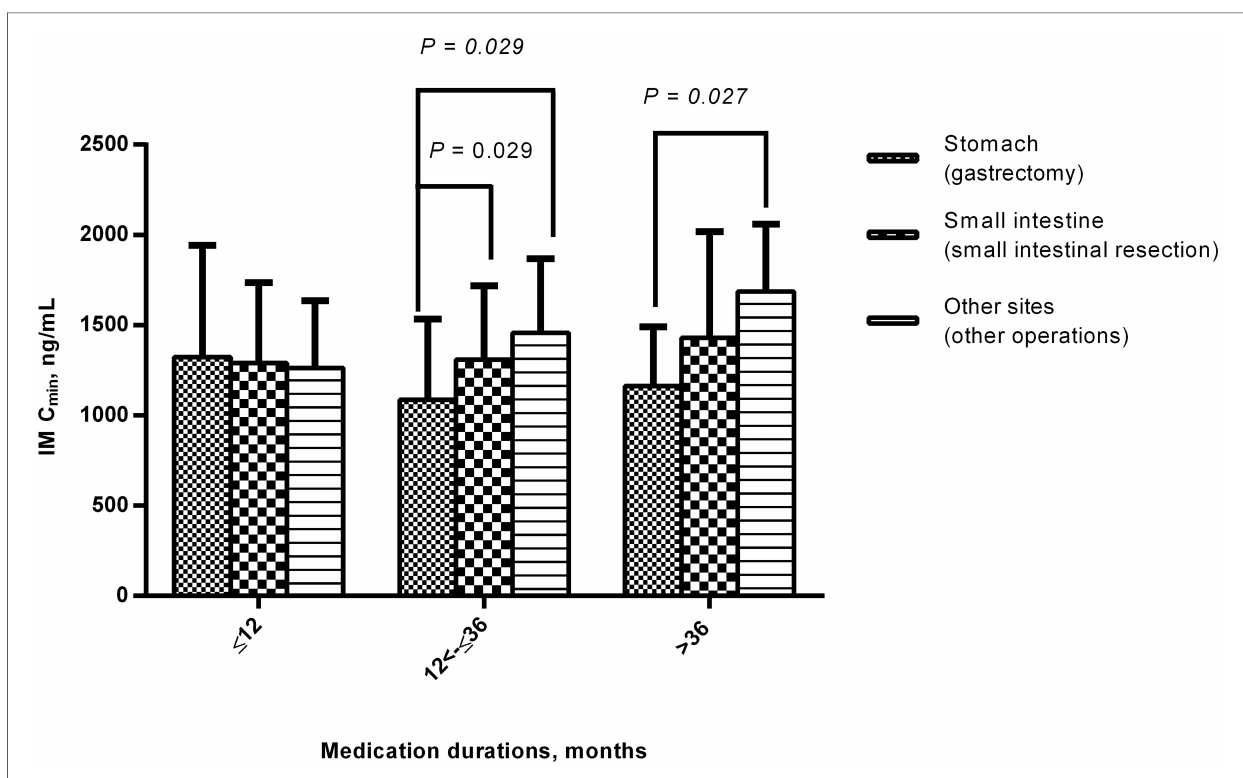
FIGURE 4 Comparison of IM C min among different primary site or surgical procedure groups during the medication period. When the medication duration was 12< – ≤ 36 months and >36 months, IM C min was signi fi cantly higher in patients with the primary site of the small intestine (small intestinal resection) or other sites (other operations) than the stomach (gastrectomy). IM, imatinib; C min , plasma trough levels.